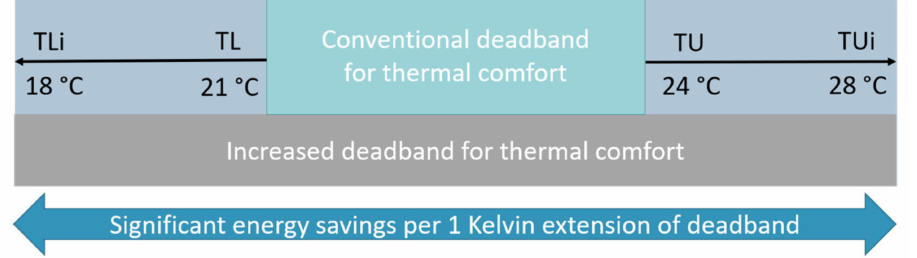
Figure 5. Increased deadband compared to a conventional deadband: the deadband is marked with the lower setpoint temperature TL (heating setpoint) and the upper setpoint temperature TU (cooling setpoint); TLi and TUi mark the initial setpoints for the adaptive